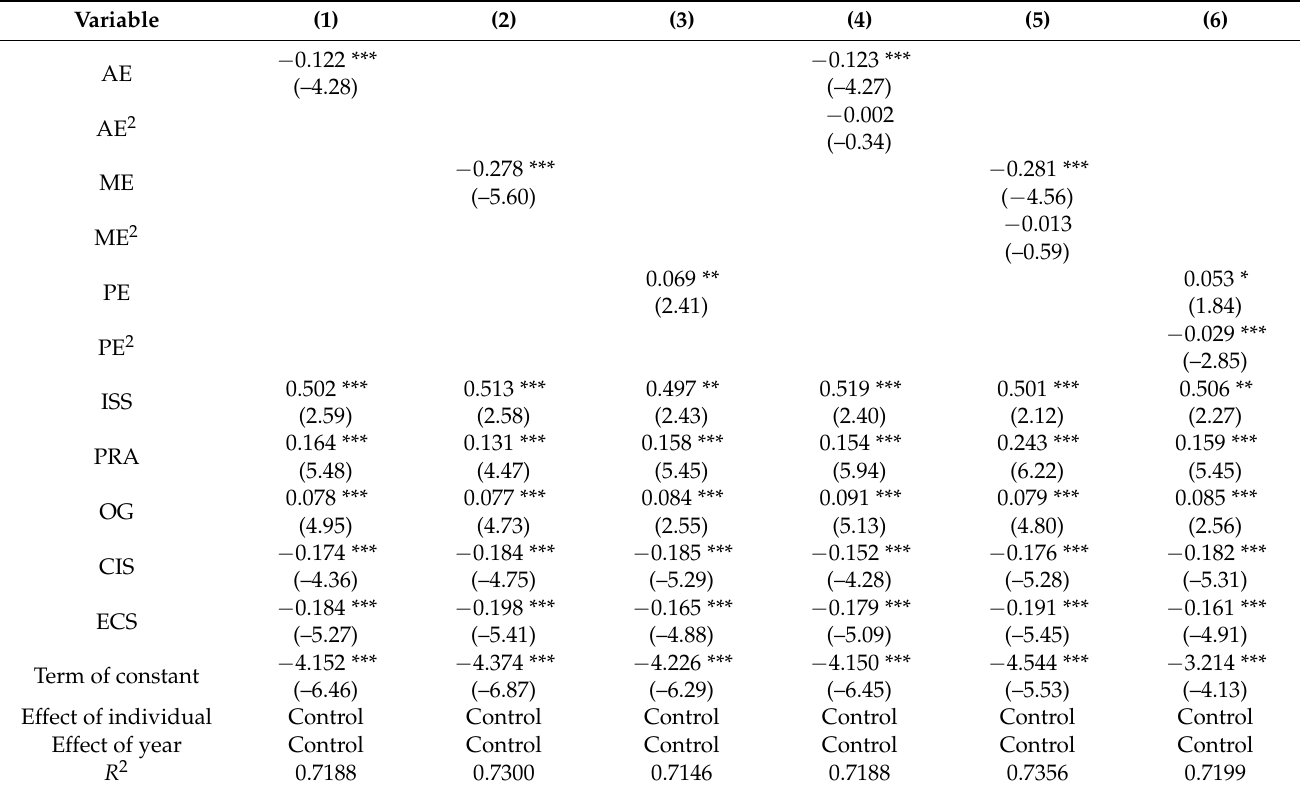
Table 2. Baseline regression